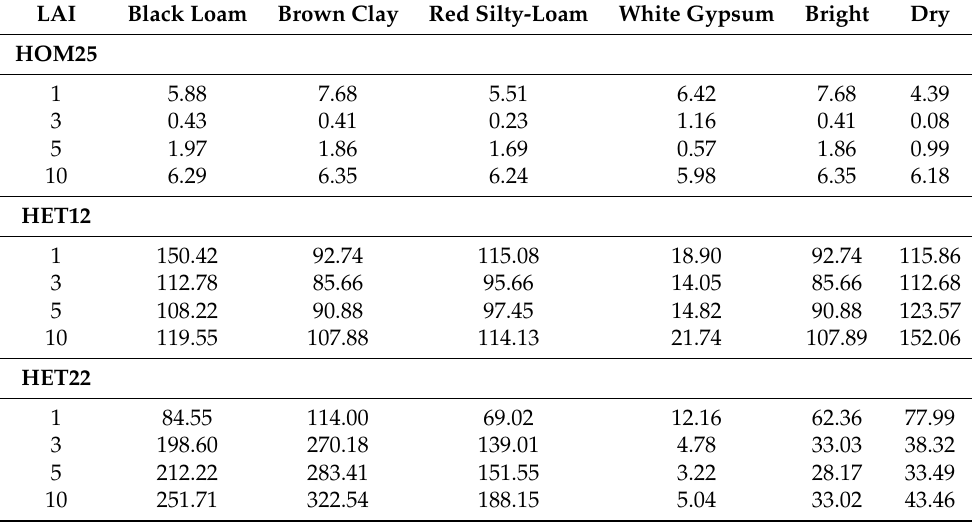
Table 4. SSE values for 6 different soil spectra for HOM25, HET12 (medium density) and HET22 (high density) canopies for LAI values 1, 3, 5 and 10. LAI Black Loam Brown Clay Red Silty-Loam White Gypsum Bright